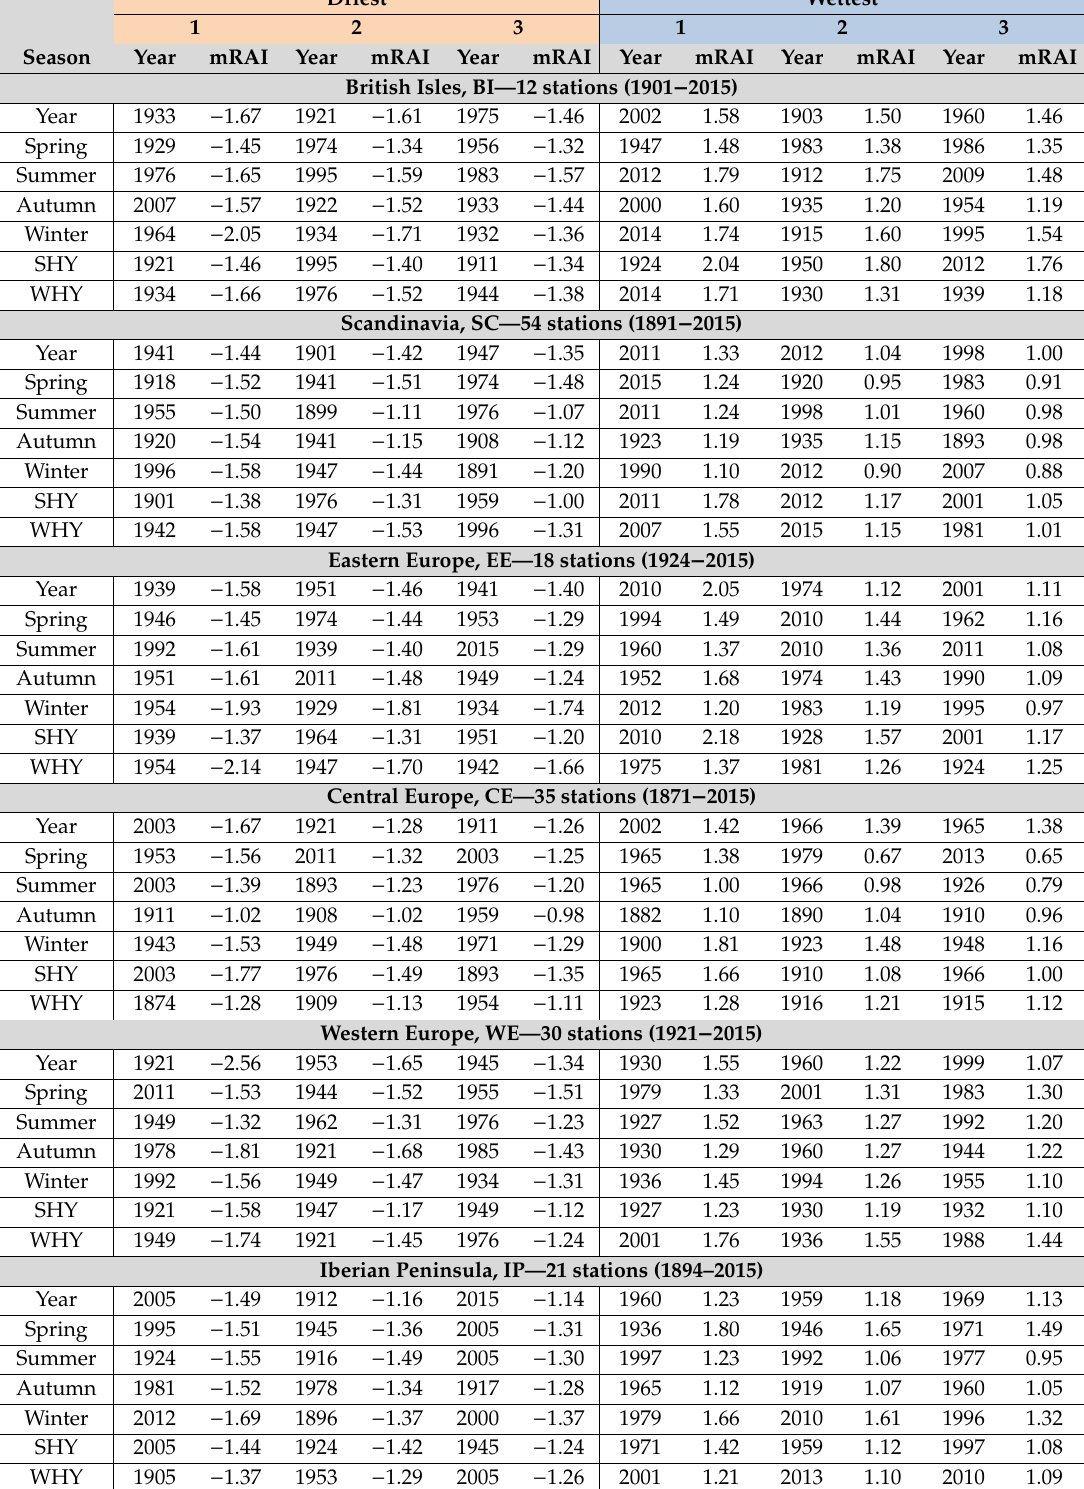
Table A9. Overview over the three driest and wettest years, seasons, and half years for the eight sub-regions as identified by the mRAI (mRAI-12 for December for the Year, mRAI-6 for September / March for the summer / winter half year, and mRAI-3 for May / August / November / February for the seasons spring / summer / autumn / winter). The study period as well as the number of stations are stated for each sub-regions individually in the